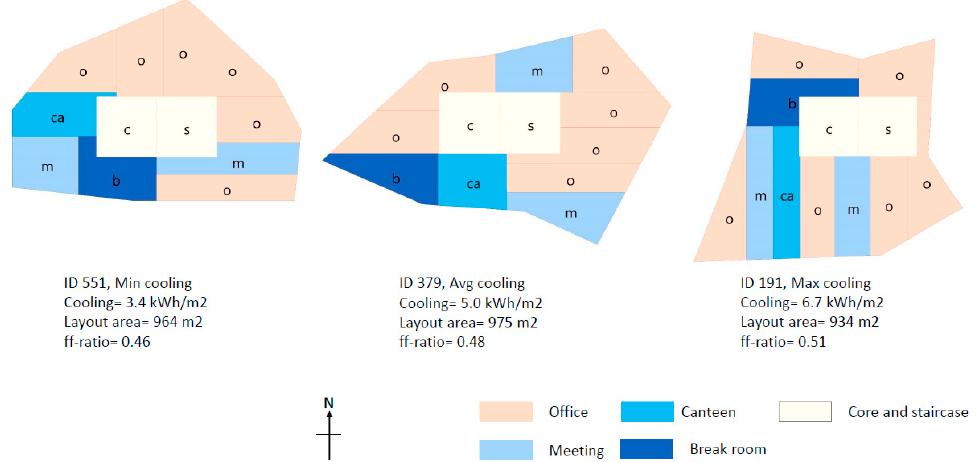
Figure 10. The layout with minimum cooling demand, average cooling demand and maximum cooling demand, resulting from the optimisation for minimising cooling demand.